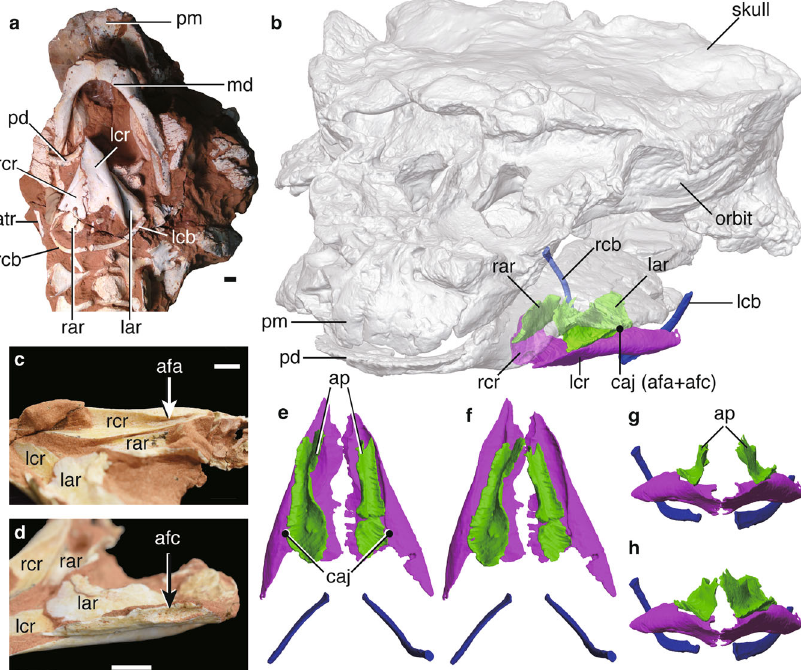
Fig. 1 in situ hyolaryngeal apparatus and skull of Pinacosaurus . a Ventral view and b 3D reconstruction of skull, mandible, and hyolaryngeal apparatus in left oblique view. c Crico-aryteniod joint of right cricoid in medial view. d The joint of left arytenoid in dorsolateral view. e Arytenoid position in glottal opening and f glottal closing in anterior views. g Arytenoid position in glottal opening and h glottal closing in dorsal views. Abbreviations: afa, articular facet for arytenoid; afc, articular facet for cricoid; ap, arytenoid process; atr, atlas rib; caj, crico-arytenoid joint; lcb, left ceratobranchial; lcr, left cricoid; md, mandible; pm, premaxilla; pd, predentary; rar, right arytenoid; rcb, right ceratobranchial; rcr, right cricoid. Scale bars, 1 cm. Photograph by Michael D ’ Emic and edited by JY in a